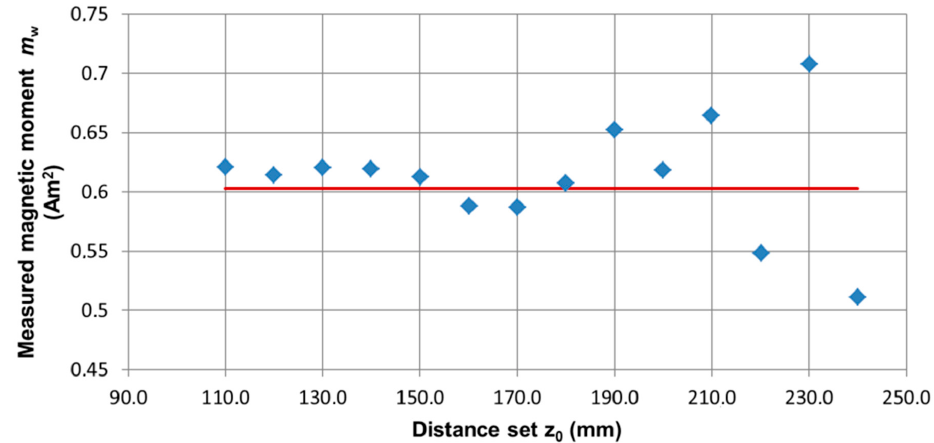
Figure 9. The dependence of the value of the determined magnetic moment of the object ( m w ) on the set distance z 0 . Position of the ME8 standard ( x 0 , y 0 , z 0 ) = (0, 0, 110:240) mm. Red line— m value of the